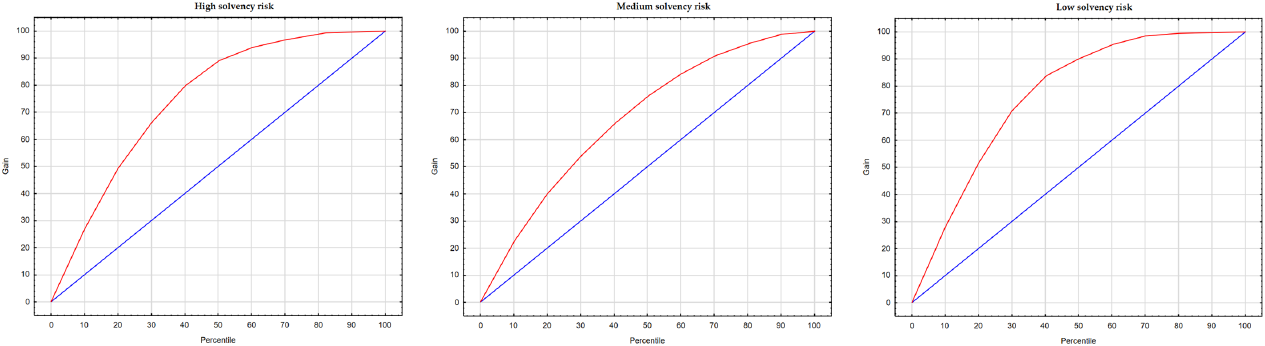
Figure 4. Gains charts for solvency risk categories, 2011–2019. Note: the blue line in the graphs shows the baseline result—the classification obtained by chance—and the red line shows the performance of our model. Source: STATISTICA output.